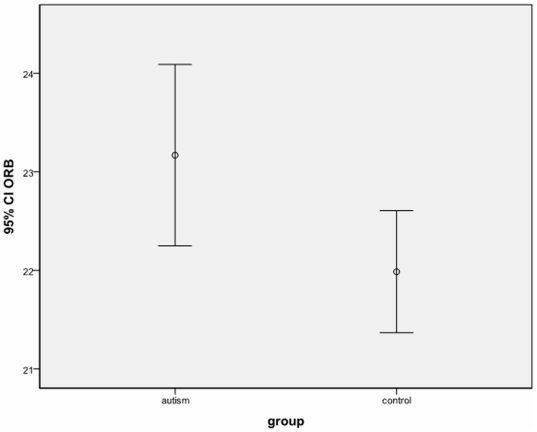
Group differences in inter-orbital distance (n = 91).CI, 95% confidence interval; ORB, interorbital distance in mm.